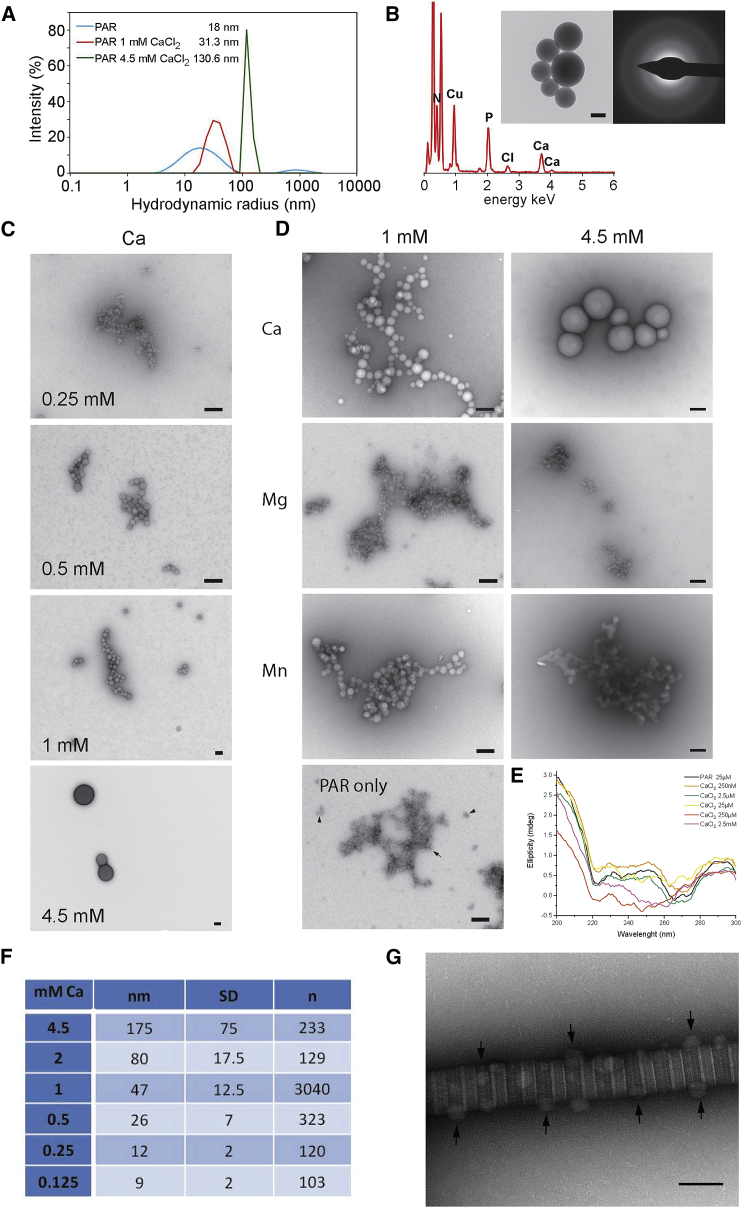
PAR Has Considerable Ca2+ Binding Capacity(A) Hydrodynamic radius of PAR in the presence of Ca2+ measured by DLS. See also Figure S4A.(B) EDX and SAED (inset, right) of PAR-Ca spheres observed by TEM (inset, left). See Figure S4B for details of analysis.(C) PAR-Ca spheres increase in diameter with Ca2+ concentration.(D) Comparison of the morphology of PAR in the presence of Ca2+ compared with other divalent metal ions and PAR alone. Scale bars, 100 nm for (B)–(D). See also Figure S4C.(E) CD spectra of PAR + Ca2+ as a function of Ca2+ concentration.(F) PAR-Ca sphere diameter as a function of Ca2+ concentration. See Figure S4B for details of analysis.(G) Bright-field (BF)-TEM of collagen fibrils incubated with PAR in the presence of calcium ions (0.5 mM CaCl2) showed that calcium-rich PAR spheres were found almost exclusively bound to the surface of the collagen fibrils preferentially at the hole zones (arrows). See Figure S4D for details of analysis.